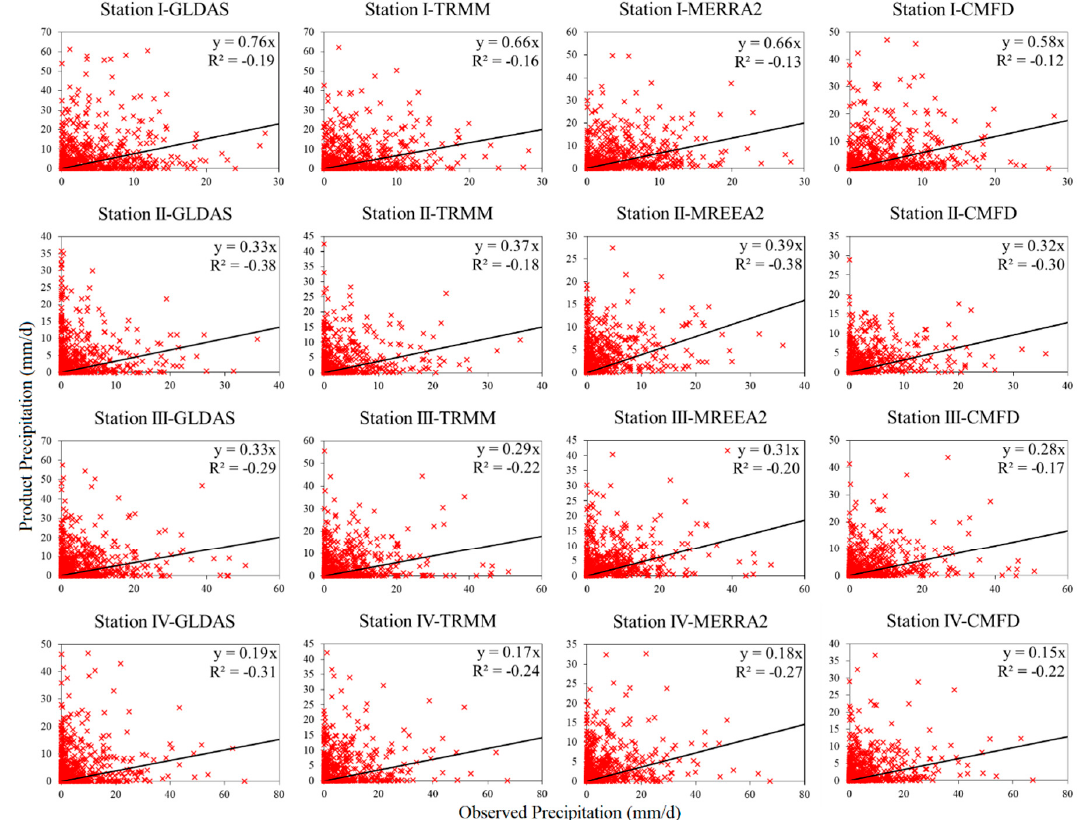
Figure 5. Relationship between the daily precipitations of products and four China Meteorological Administration stations.